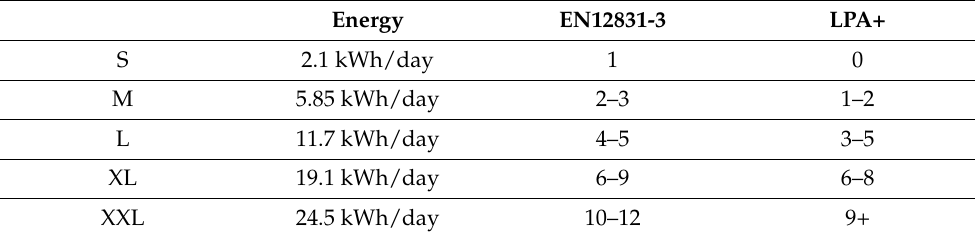
Table 2. Correlation between tapping profile and number of